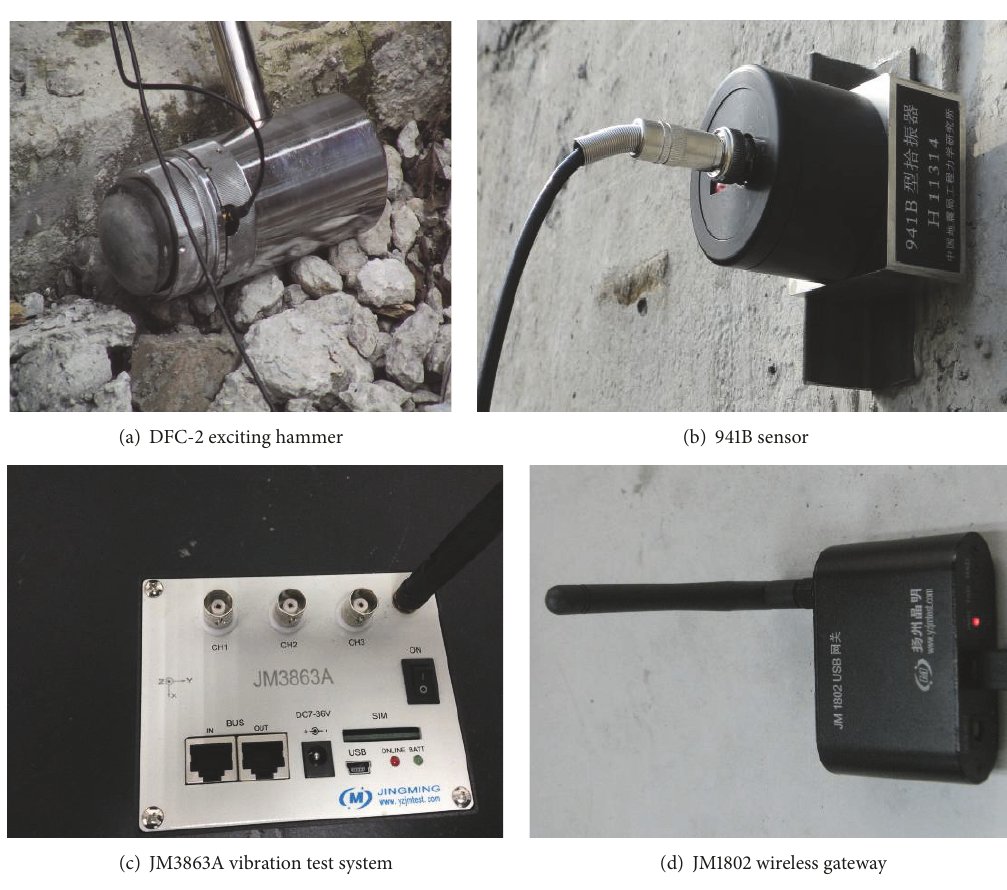
Figure 9: Equipment for the vibration tests. Table 1: Material parameters of the concrete and